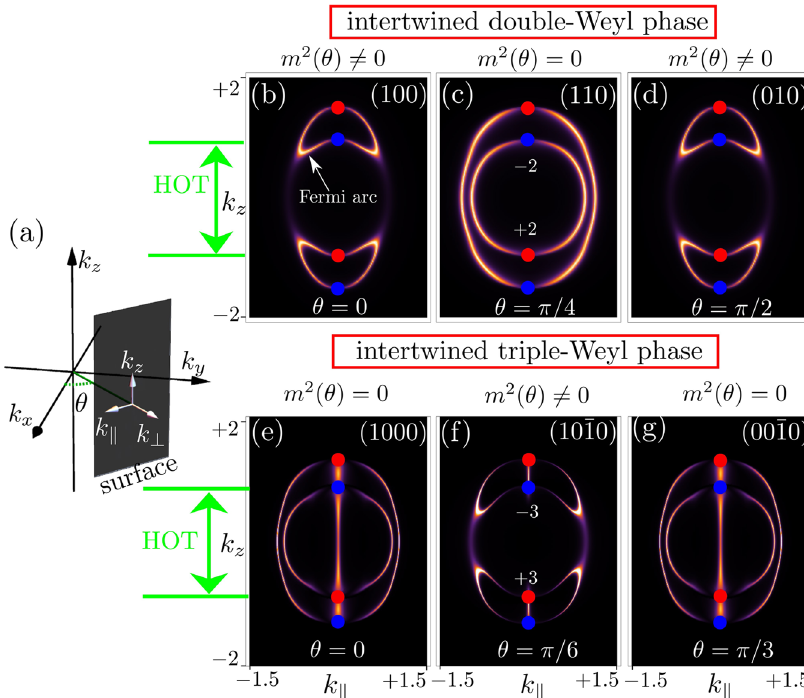
Fig. 2 The intertwining results in the change of Fermi-arc topology in a periodic pattern. a The relation between different coordinate systems. θ indicates the orientation of the surface (black plane), on which the local density of states is computed numerically. b – d Fermi arcs of intertwined double-Weyl phase in a full period of θ ∈ [0, π /2]. Each projected double-Weyl point emits two Fermi arcs on the surface. The topology of Fermi arcs changes when rotating from the (100) surface ( θ = 0) to the (110) surface ( θ = π /4), and it returns to the initial topology after rotating further to the (010) surface ( θ = π /2), completing one period. e – g Fermi arcs of intertwined triple-Weyl phase in a full period of θ ∈ [0, π /3]. Each projected triple-Weyl point emits three Fermi arcs on the surface. The topology of Fermi arcs changes when rotating from the (1000) surface ( θ = 0) to the ð 1010 Þ surface ( θ = π /6), and it returns to the initial topology after rotating further to the ð 0010 Þ surface ( θ = π /3), completing one